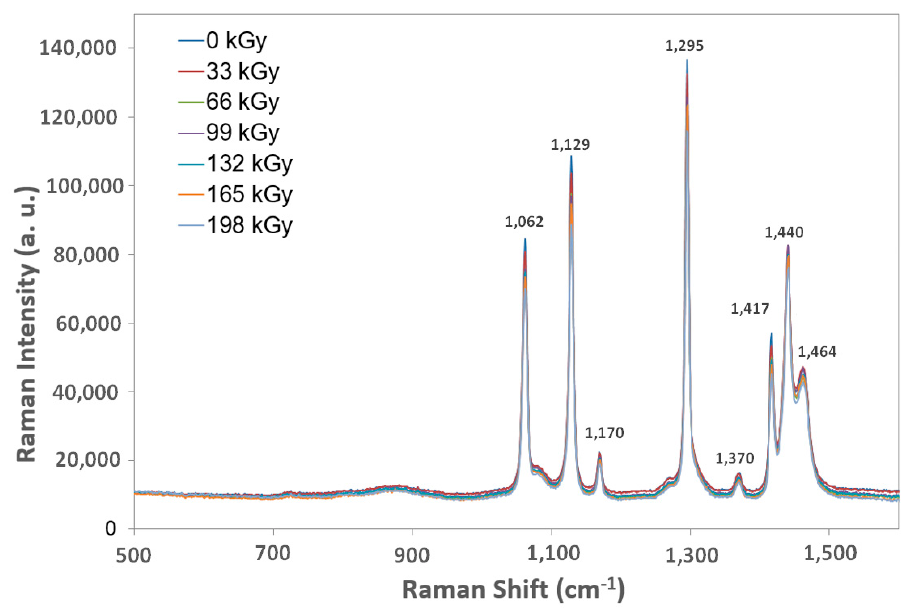
Figure 17. Raman spectroscopy of irradiated HDPE.